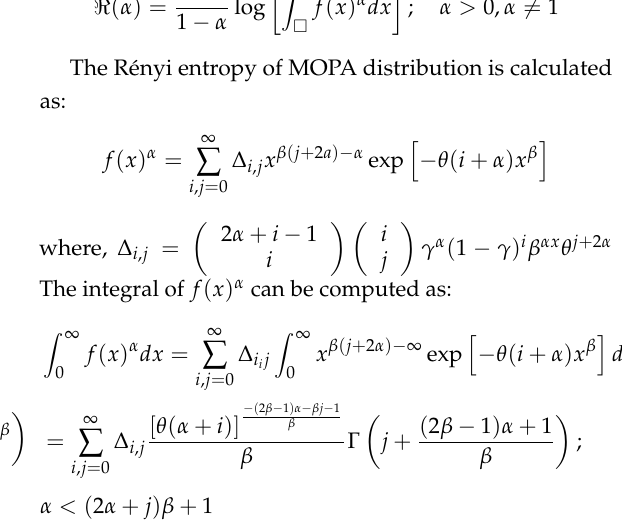
Fig. 4. Plots of MRL for MOPA distribution with some selected